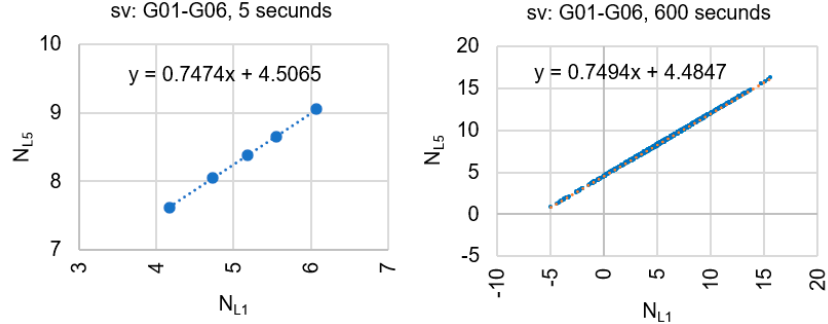
Figure 2. Scatter plot of correlated single-epoch geometry-free ambiguities N L1 and N L5